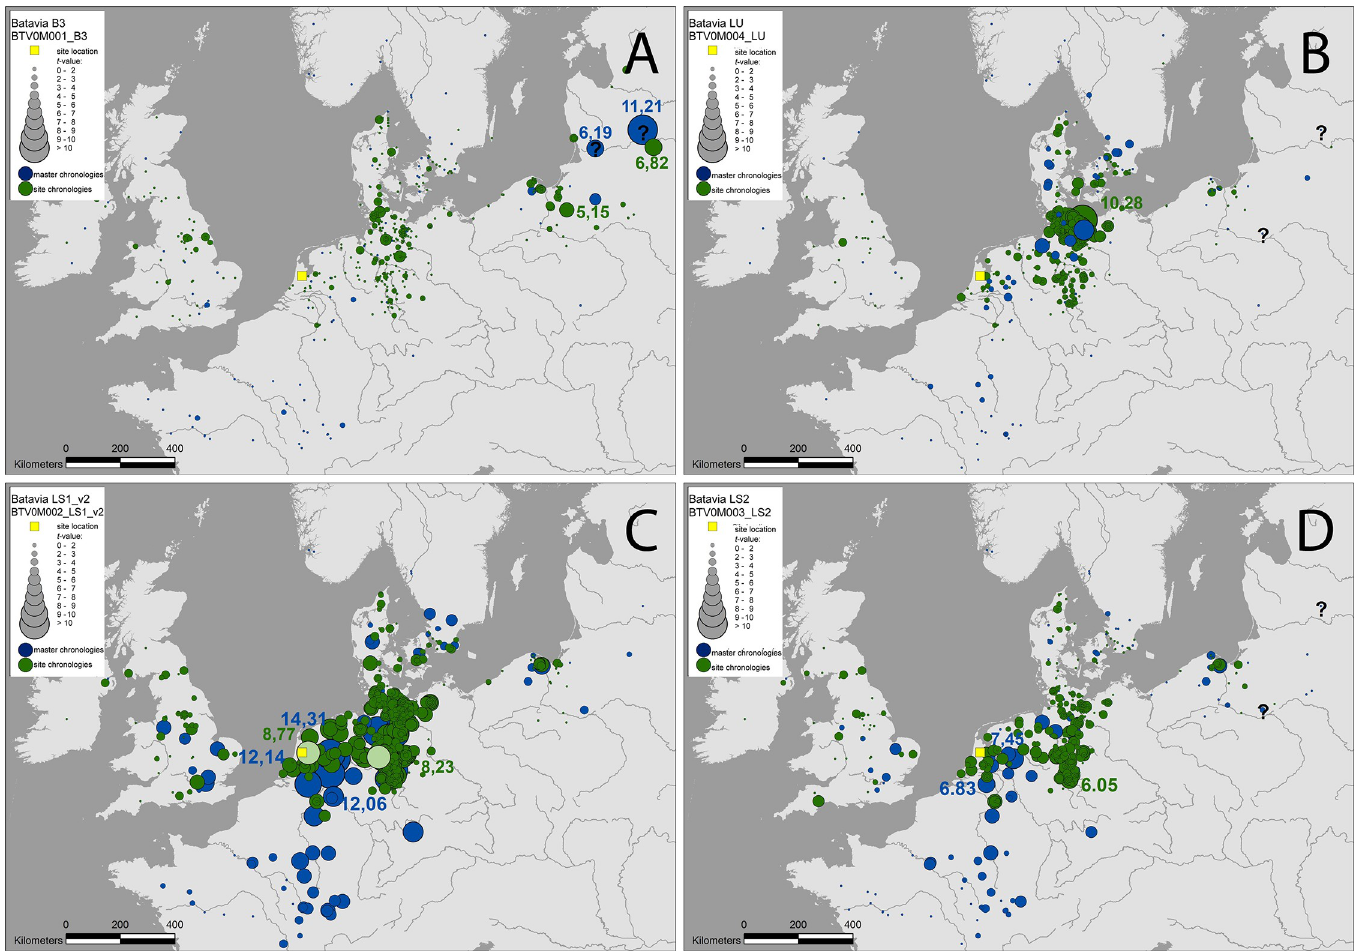
Fig 3. Timber provenance maps. Each dot represents the location of a site chronology (green) or a regional chronology (blue). The t -value is the correlation measure used here (adapted for dendrochronological studies by [31], and each circle represents the t -value achieved with each dataset—the larger the circle, the higher the t -value. (For a detailed explanation of the technique used here and the underlying tree-ring data see [26]). A) Baltic Group; B) Lu¨beck Group; C) Lower Saxony I Group; D) Lower Saxony II